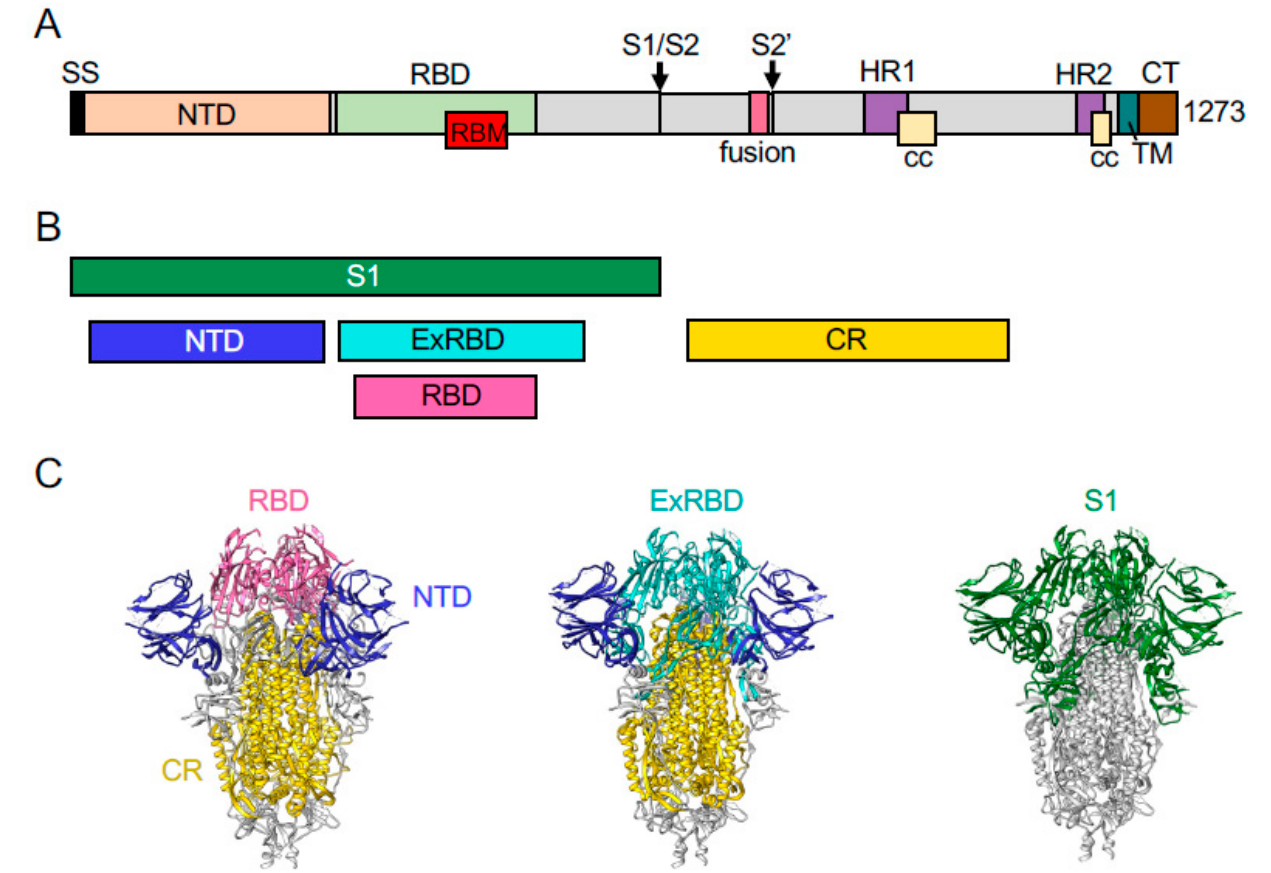
Figure 1. Domains of the SARS-CoV-2 S protein expressed by rSA11. ( A ) S protein trimers are cleaved at the S1/S2 junction by furin proconvertase and at the S2 ′ site by the TMPRSS2 serine protease. The S1 fragment contains a signal sequence (SS), N-terminal domain (NTD), receptor-binding domain (RBD), receptor-binding motif (RBM), coiled-coil (CC), and two heptad repeats (HR1, HR2). The S2 fragment contains a trimeric core region, transmembrane anchor (TM), and fusion domain. ( B ) Portions of the S protein expressed by recombinant rotaviruses are indicated. ( C ) Ribbon representations of the closed conformation of the trimeric S protein (PDB 6VXX) showing locations of the RBD (magenta), extended RBD (ExRBD, cyan), NTD (blue), core (CR, gold) domains and the S1 cleavage product (green).